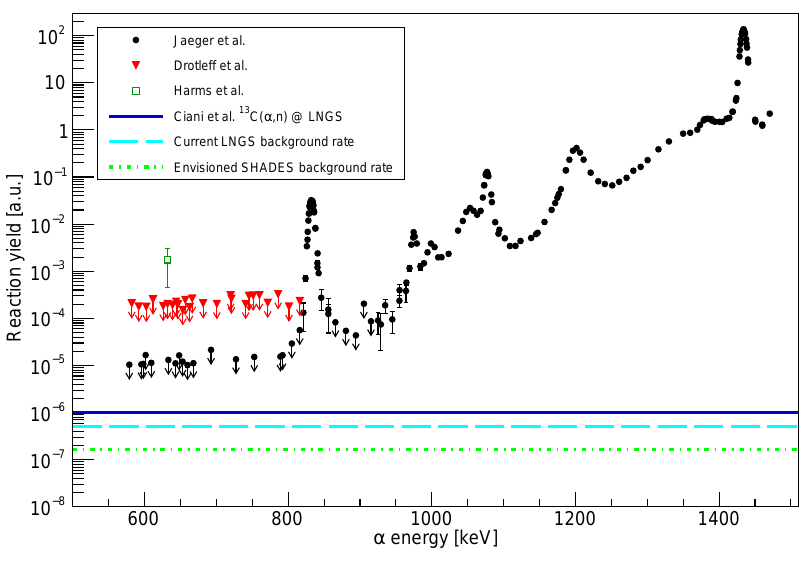
Figure 1. Reaction yield data from Jaeger et al. ([8], black circles), Drotle ff et al. ([9], red triangles) and Harms et al. ([10], green rectangle). The background level estimated for the 13 C( α, n) 16 O LUNA measurement campaign [2] and the one envisioned for SHADES are also shown. See the text for more